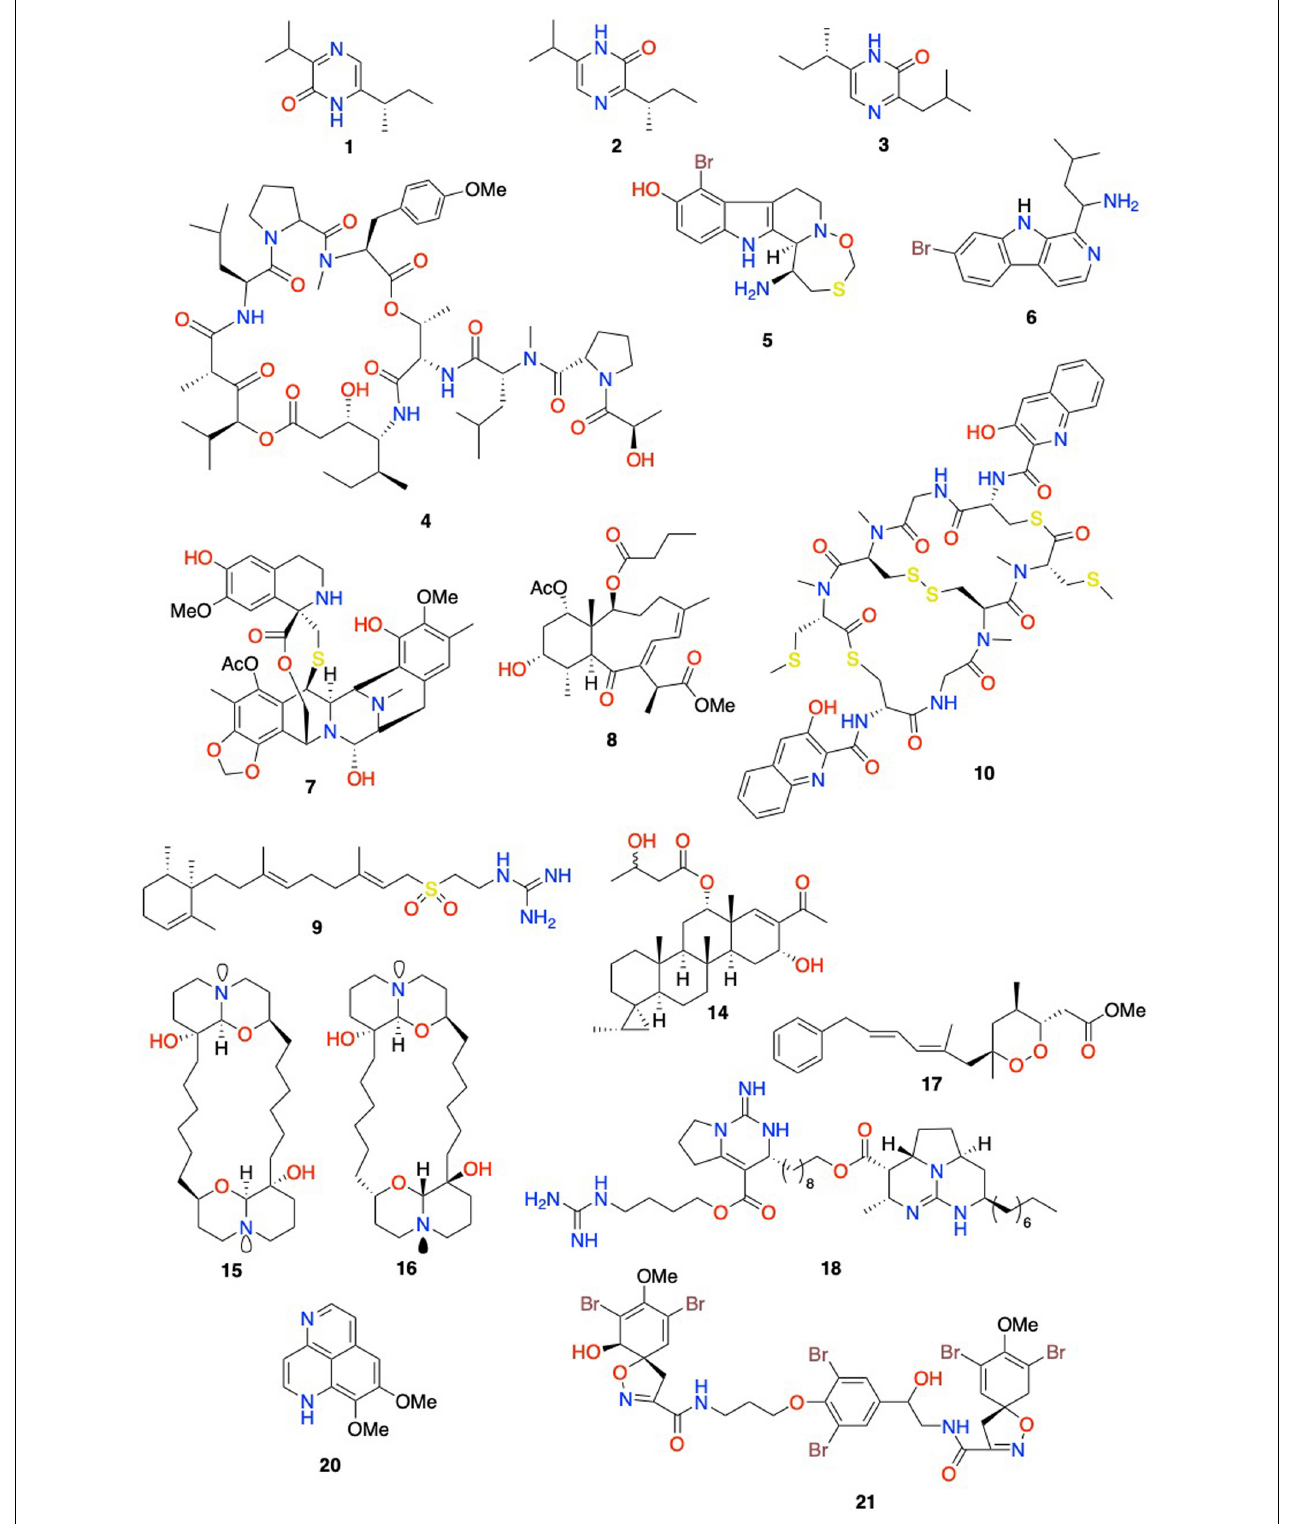
FIGURE 3 | Selected structures of compounds with reported antiproliferative activities displayed in Table 1 . 1 : (S)-6-(sec-butyl)-3-isopropylpyrazin-2(1 H )-one; 2 : (S)-3-(sec-butyl)-6-isopropylpyrazin-2(1 H )-one; 3 : (S)-6-(sec-butyl)-3-isobutylpyrazin-2(1 H )-one; 4 : didemnin B; 5 : eudistomin E; 6 : eudistalbin A; 7 : ecteinascidin 743; 8 : briareolate ester L; 9 : ( − )-agelasidine C; 10 : thiocoraline; 14 : scalarane sesterpenoid; 15 : araguspongine C; 16 : meso-araguspongine C; 17 : cyclic peroxide methyl capucinoate A; 18 : norbatzelladine A; 20 : aaptamine; 21 : 11-deoxyfistularin-3.